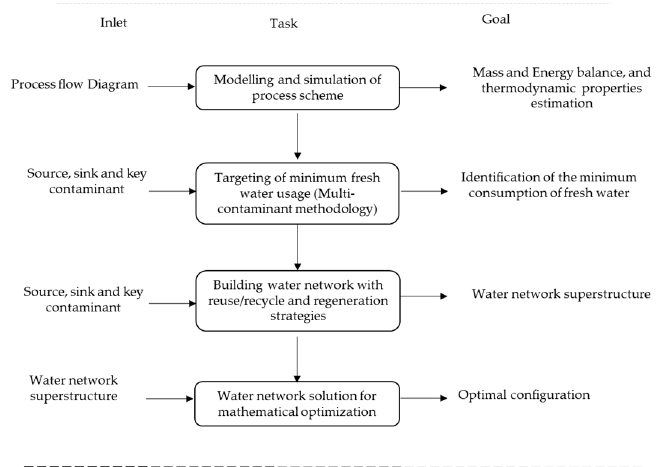
Figure 1. Methodological